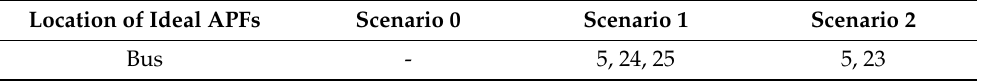
Table 5. Location of installed SACAPFs in the network with multiple nonlinear